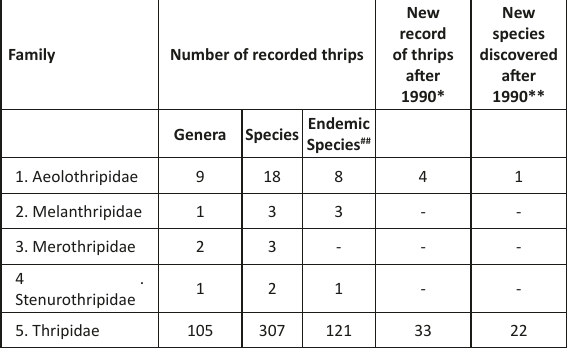
Table 1. Profile of Indian thrips fauna of the suborder